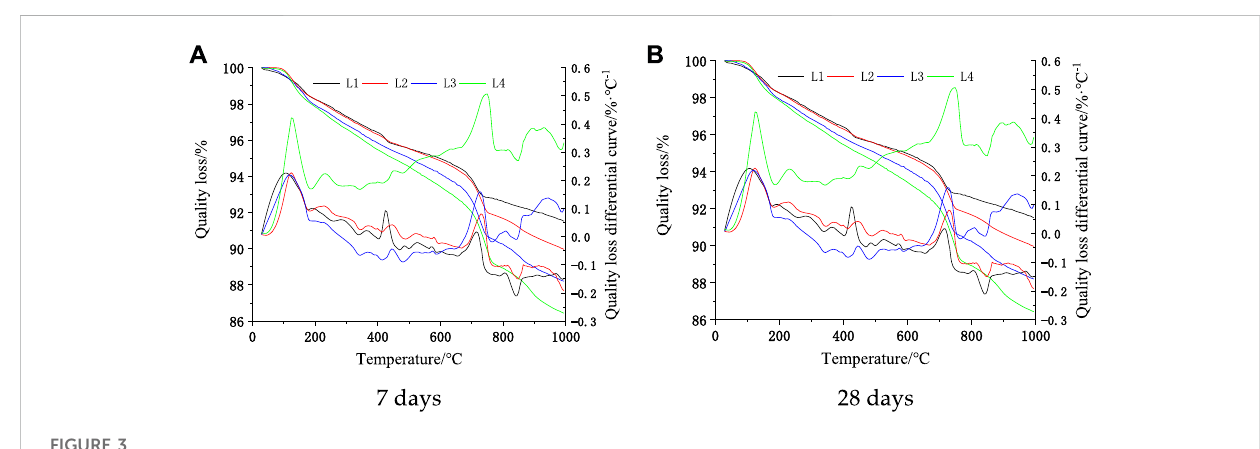
FIGURE 3 TG curve of cement paste with lithium slag.